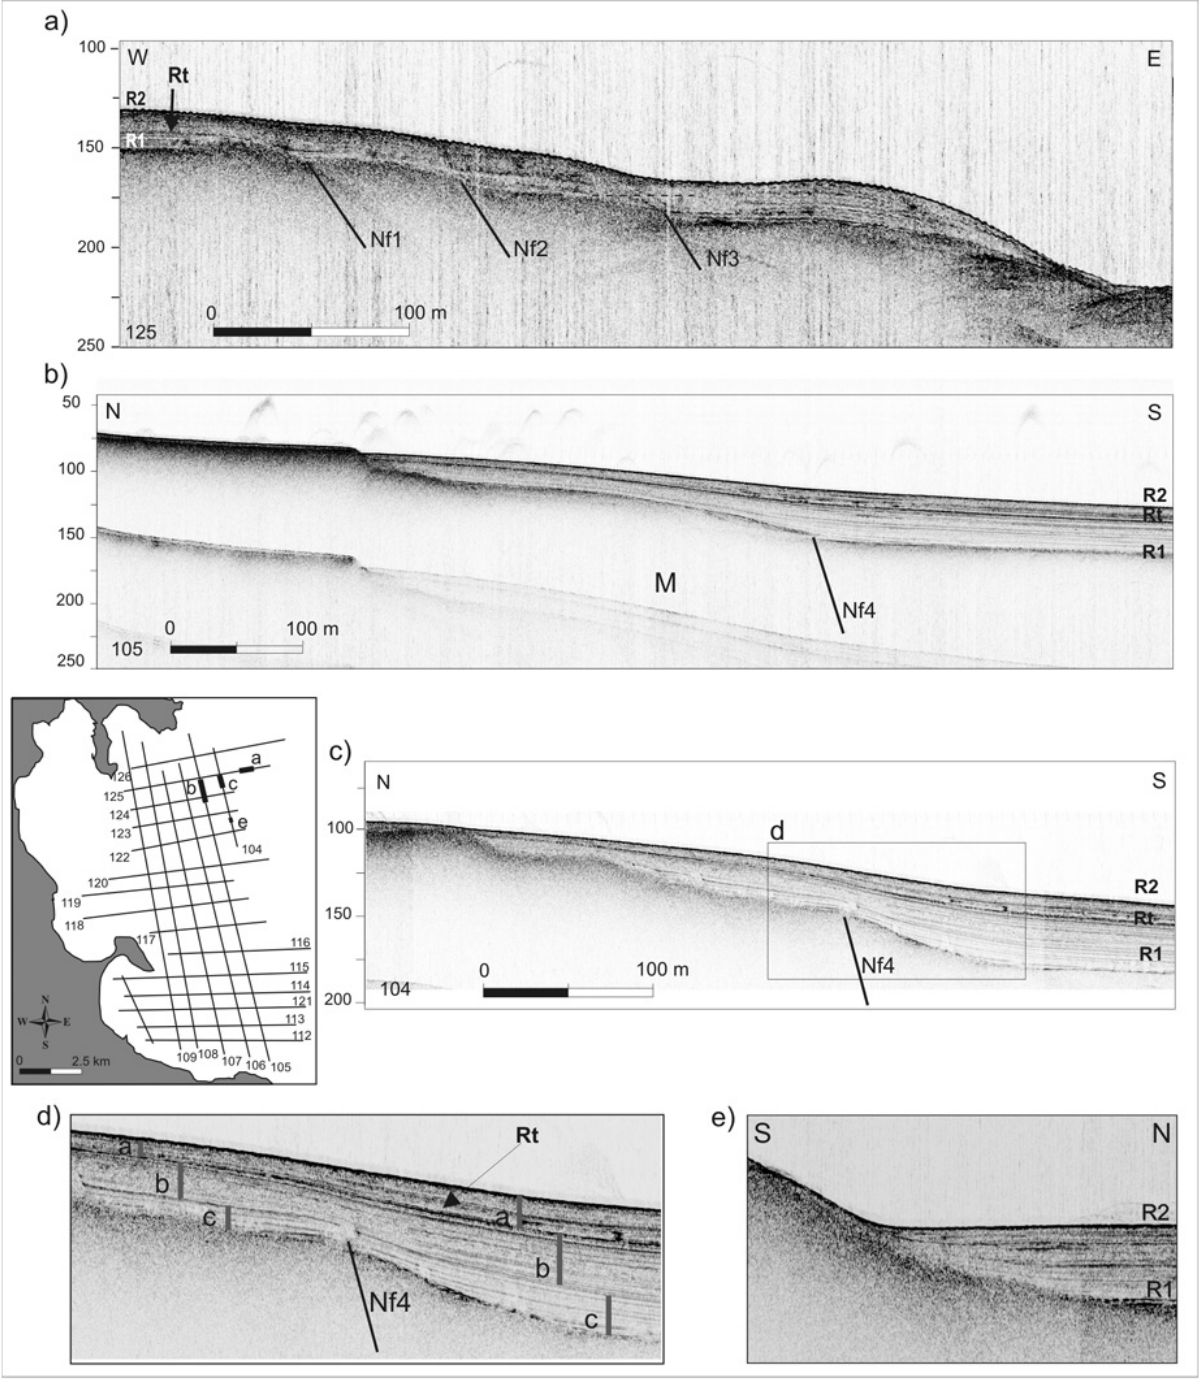
Figure 10. Location of the sections is shown in the profile grid (thick lines); a) 125 Chirp profile located in the northern sector showing the flight of scarps created by normal faults, involving the R1 reflector; b) profile 105 showing Nf4 fault displacing R1; c) scarp coinciding with Nf4 fault affecting R1 reflector; rectangle refers to the blow-up of Figure 10d); d) detail of profile 104 showing probable active deformation of the Seismo Unit B semitransparent deposit; growth strata are imaged in the hangingwall of the Nf4 fault; e) detail of the same 104 Chirp line where strata on-lap the